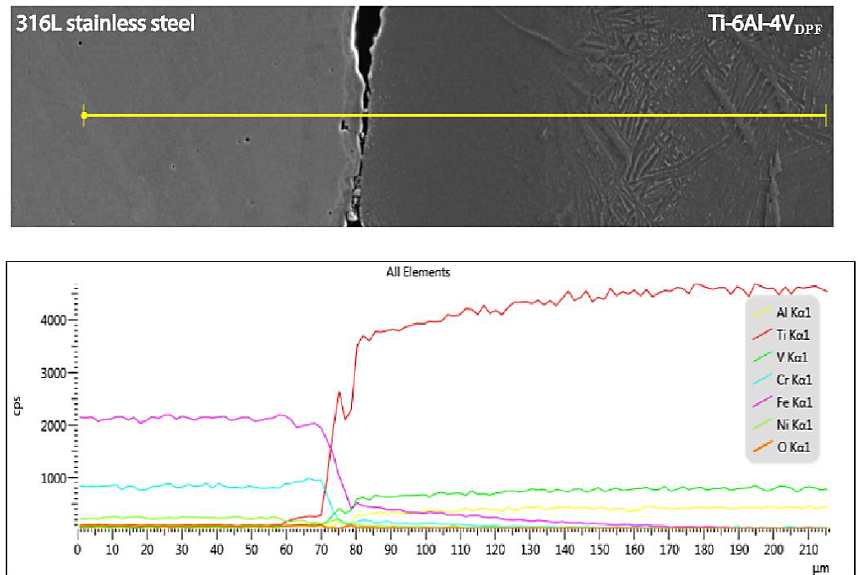
Figure 8. Typical backscatter electron micrograph and EDS linescan analysis of the interface between the stainless steel canister and the Ti-6Al-4V DPF.